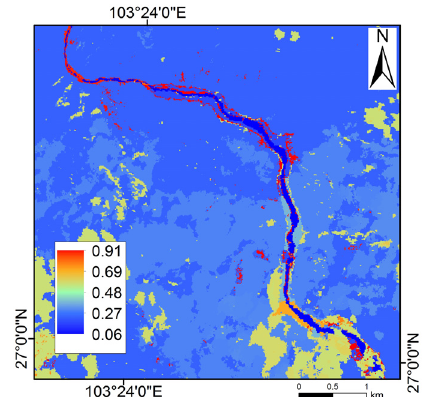
Figure 6. Spatial distribution of conflict degrees between the input